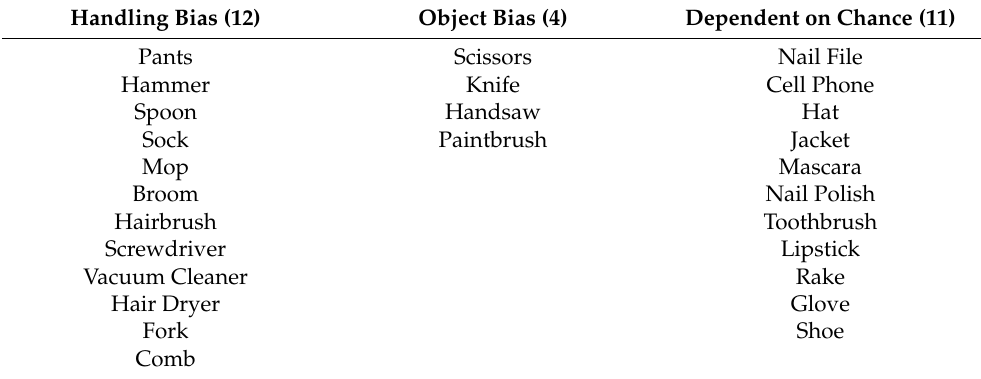
Table 6. Binomial tests revealed that overall, 12 items were more likely to elicit a Handling handshape and 4 items were more likely to elicit Object handshapes, while 11 items were statistically at chance. Handling Bias (12) Object Bias (4) Dependent on Chance (11) Pants Scissors Nail File Hammer Knife Cell Phone Spoon Handsaw